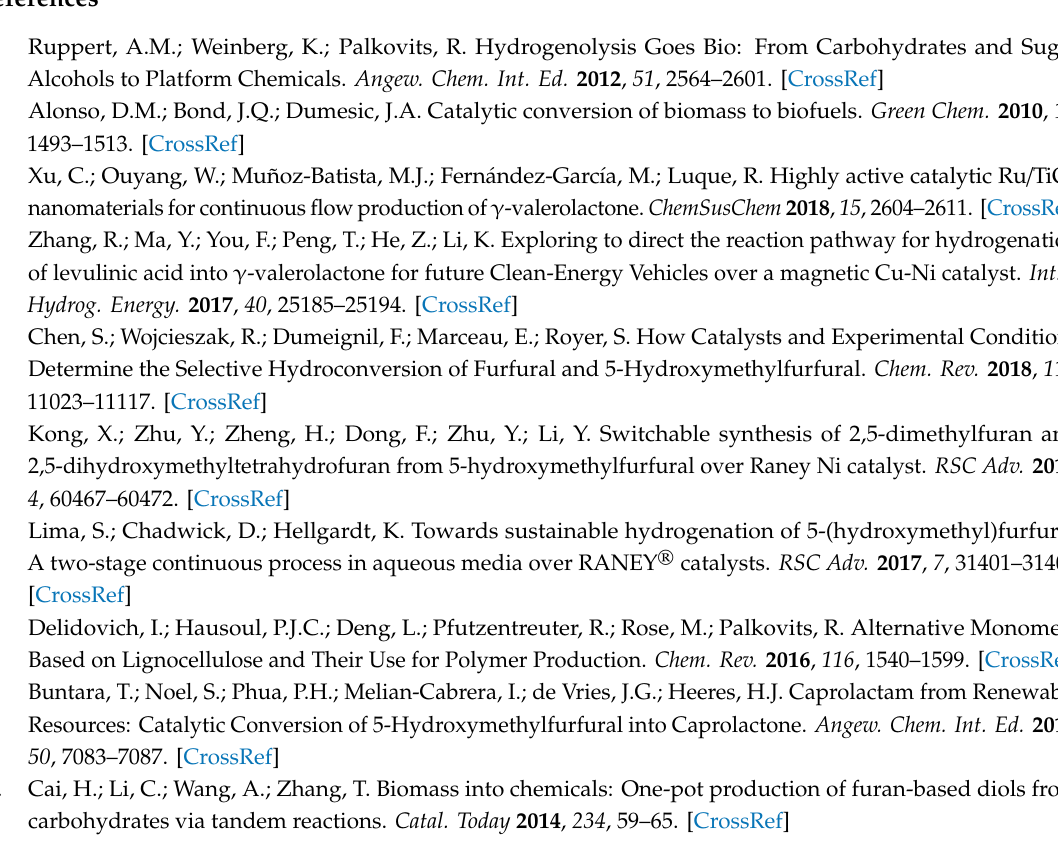
Figure S1: XRD patterns of mono- and bi-metallic catalysts, Figure S2: TPR profiles of the mono- and bi-metallic catalysts after the reduction step, Figure S3: Wide scan survey XPS spectra of the mono and bimetallic catalysts. Figure S4: FTIR spectra of CO adsorbed on the surface of (a) the monometallic and (b) the bimetallic catalysts recorded after CO